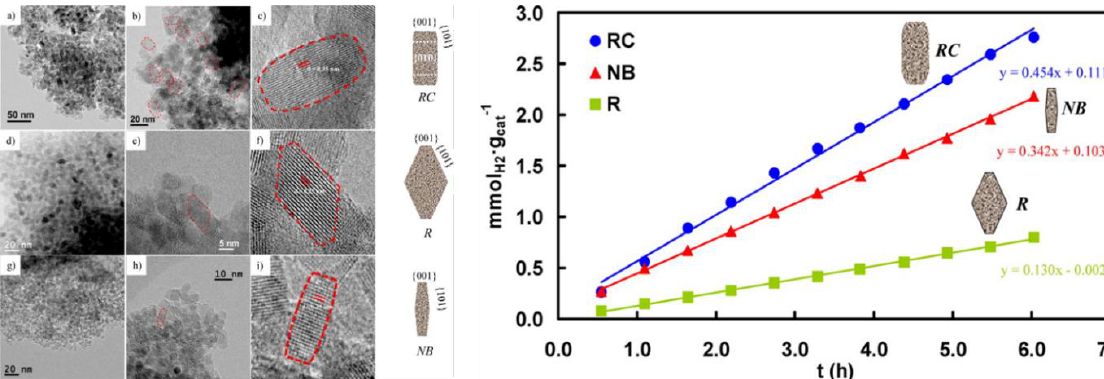
Figure 7. Left : Transmission Electron Microscopy (TEM) and High Resolution Transmission Electron Microscopy (HRTEM) images of shape-controlled TiO 2 nanocrystals produced by solvothermal synthesis. ( a – c ) Rectangular nanoparticles (RC); ( d – f ) rhombic nanocrystals (R); ( g – i ) nanobars (NB). Right : Hydrogen evolution during the photocatalytic steam reforming of methanol on shape-controlled anatase nanocrystals. Adapted with permission from [92]. Copyright © 2015 American Chemical Society.